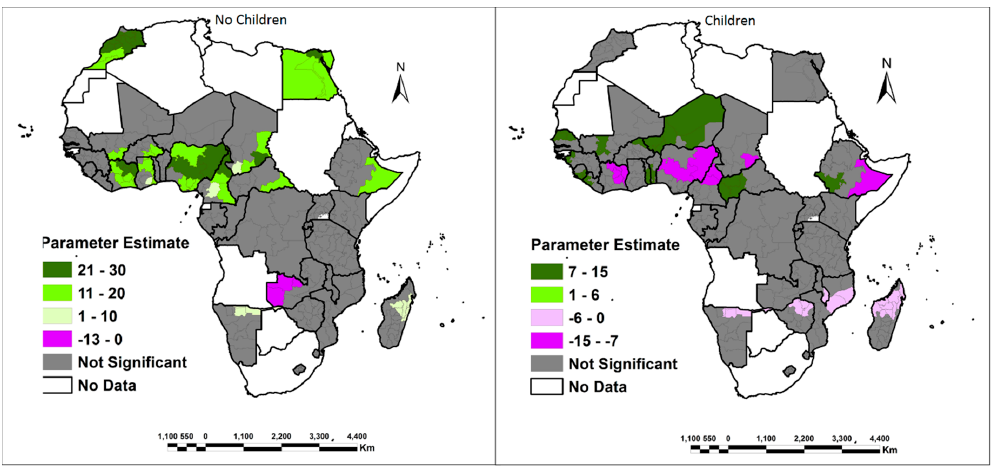
Figure 9. Spatial distribution and significance of children on women’s access to own land.